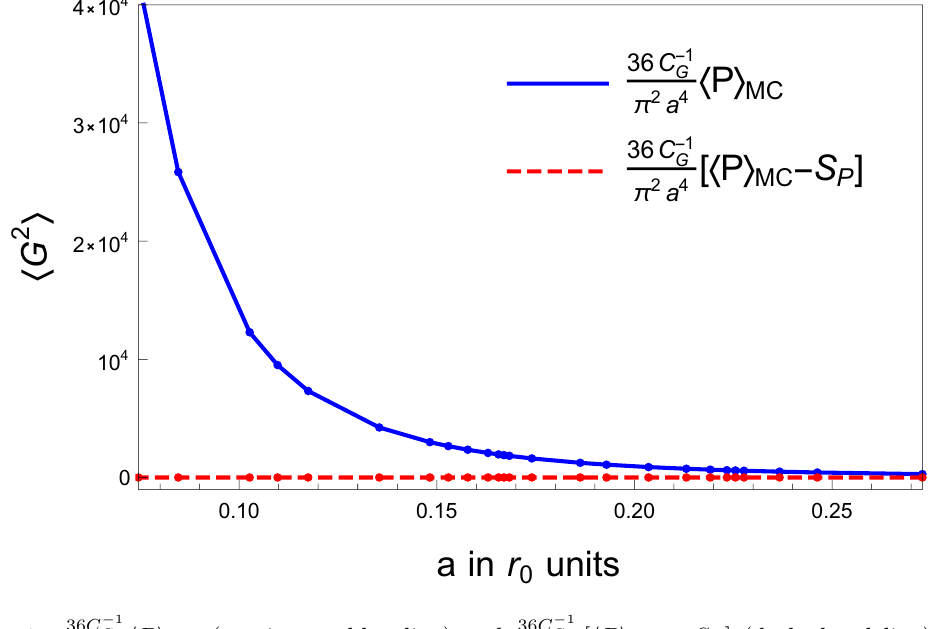
(cid:0) 1 [ h P i MC (cid:0) S P ] (dashed red line). The G (cid:25) 2 a 4